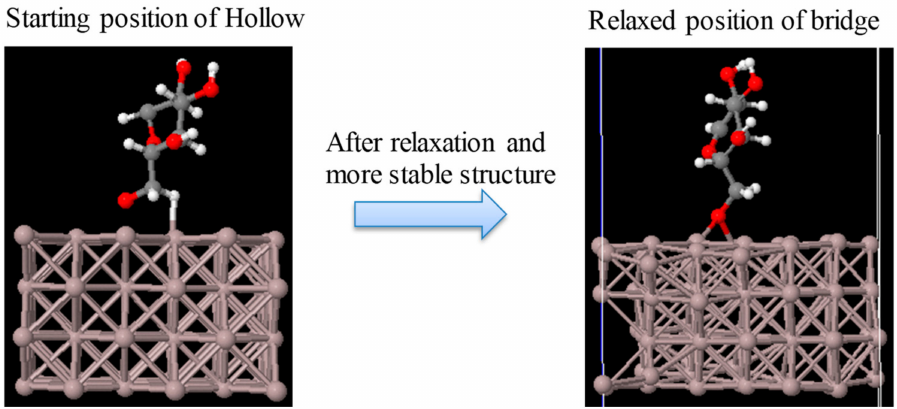
Figure 3. The optimized structure for the bridge site, which is a stable structure.